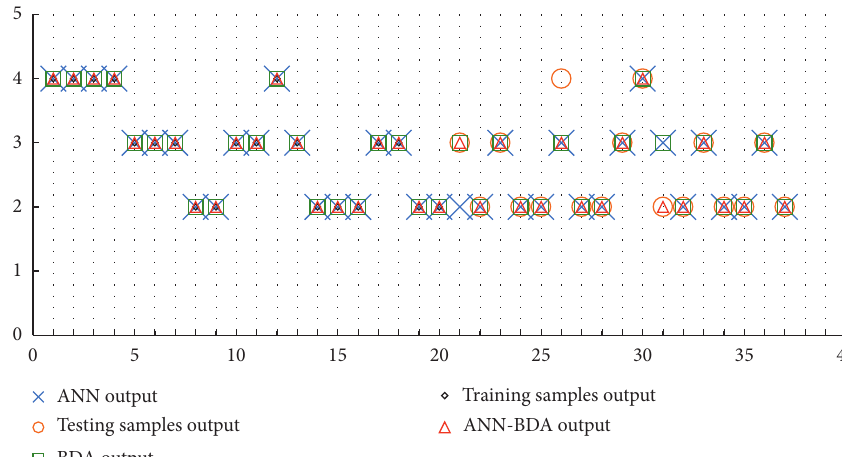
Figure 4: Training effects and the prediction results for situation